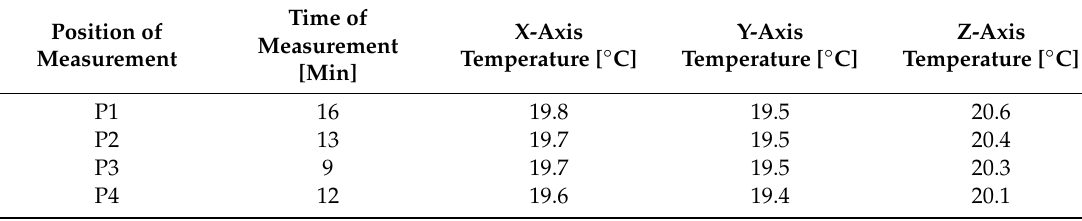
Table 5. Conditions of calibration